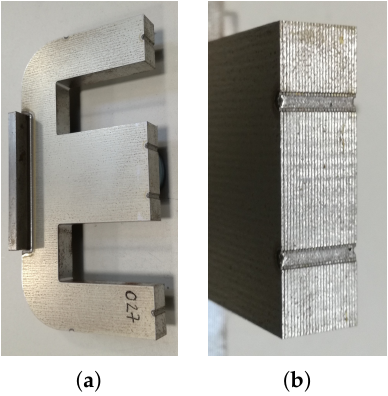
Figure 16. Stator modules; ( a ) geometry, and ( b ) zoomed view of the stack.